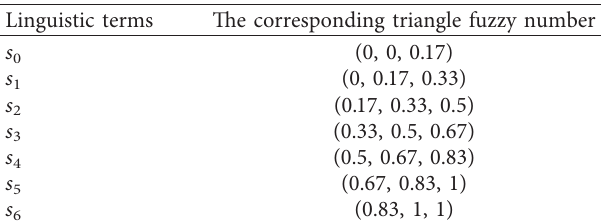
Table 2: Linguistic term set and their corresponding triangle fuzzy number.